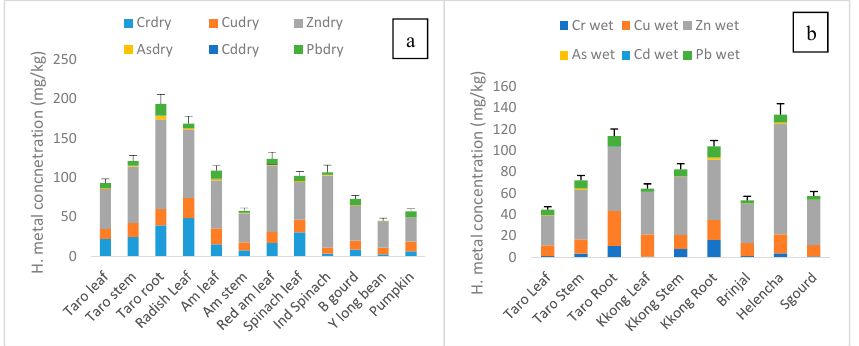
Figure 4. Heavy metal concentration ( ± standard error of the mean) in different vegetables during ( a ) dry season and ( b ) wet season.